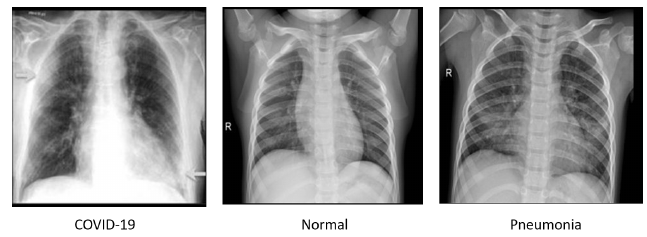
Figure 6. Few samples of chest X-ray images.